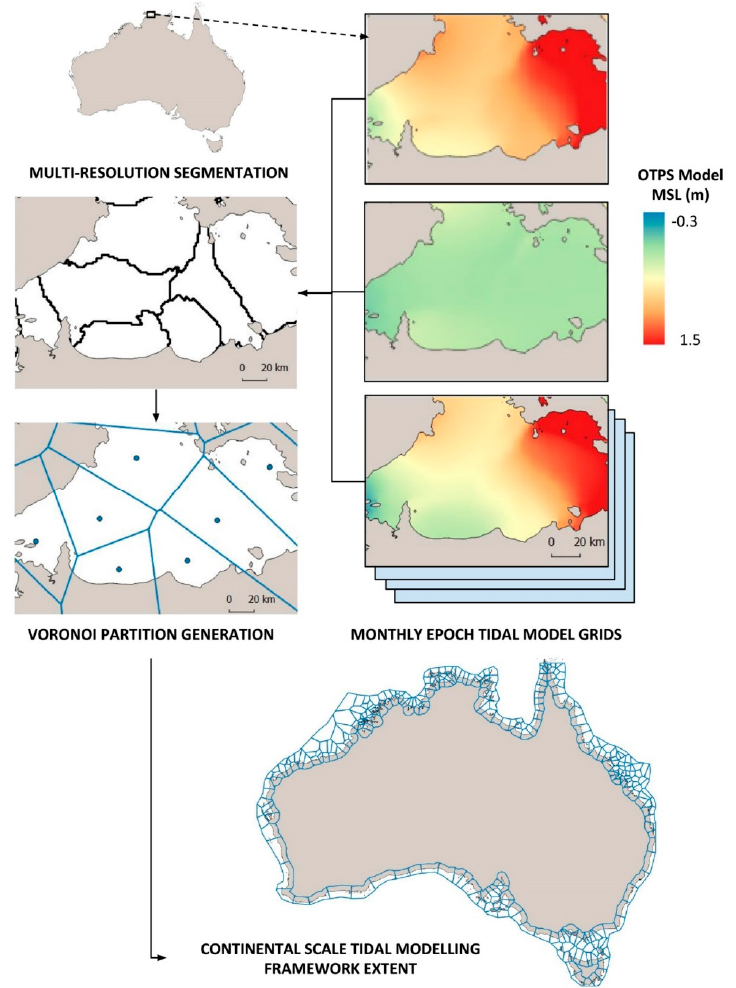
Figure 1. Conceptual diagram showing the development of the tidal modelling framework: twelve tidal height layers were generated from the OTPS TPX08 model at monthly epochs across 2016. These layers were processed using a multi-resolution segmentation, from which a Voronoi partition is generated using the centroids of the segments.